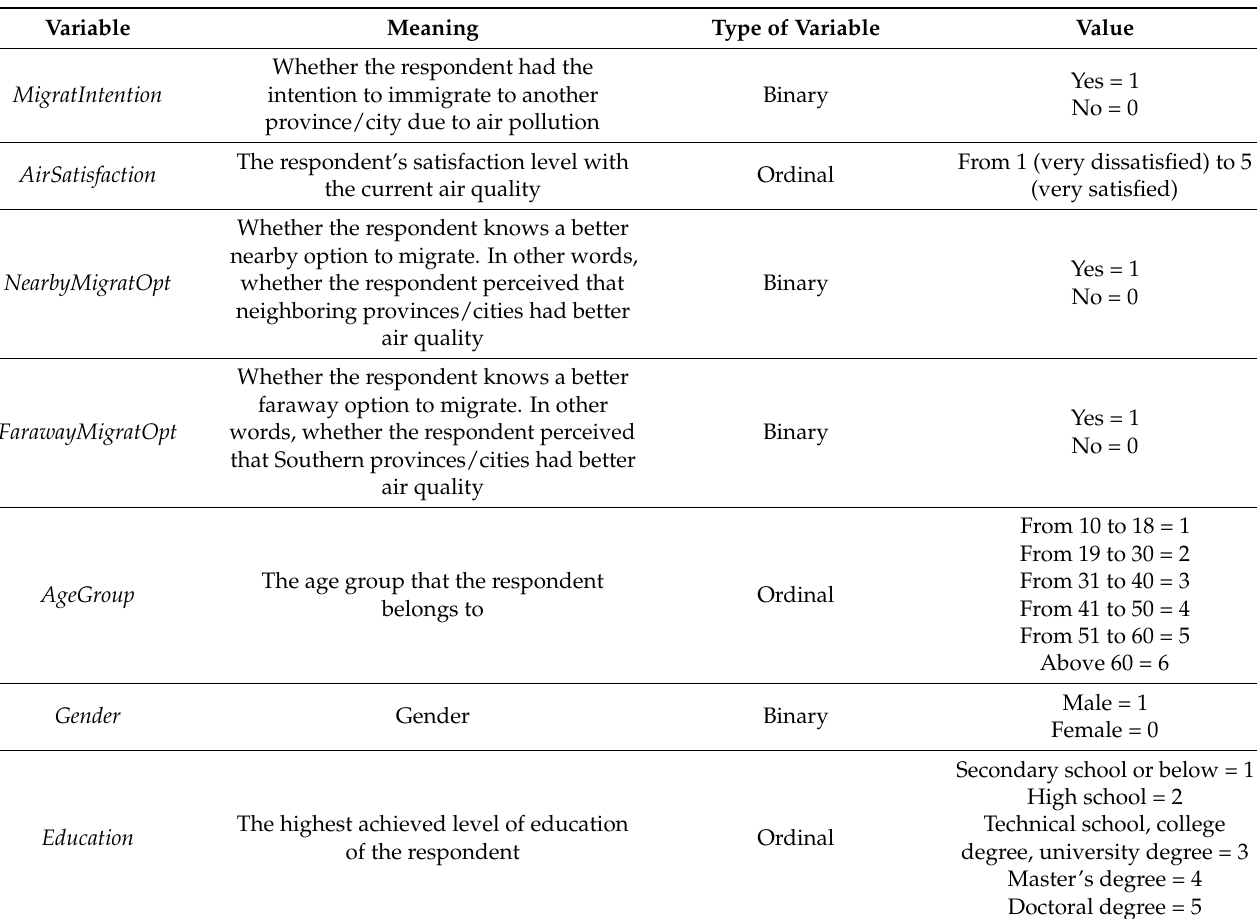
Table 1. Variable